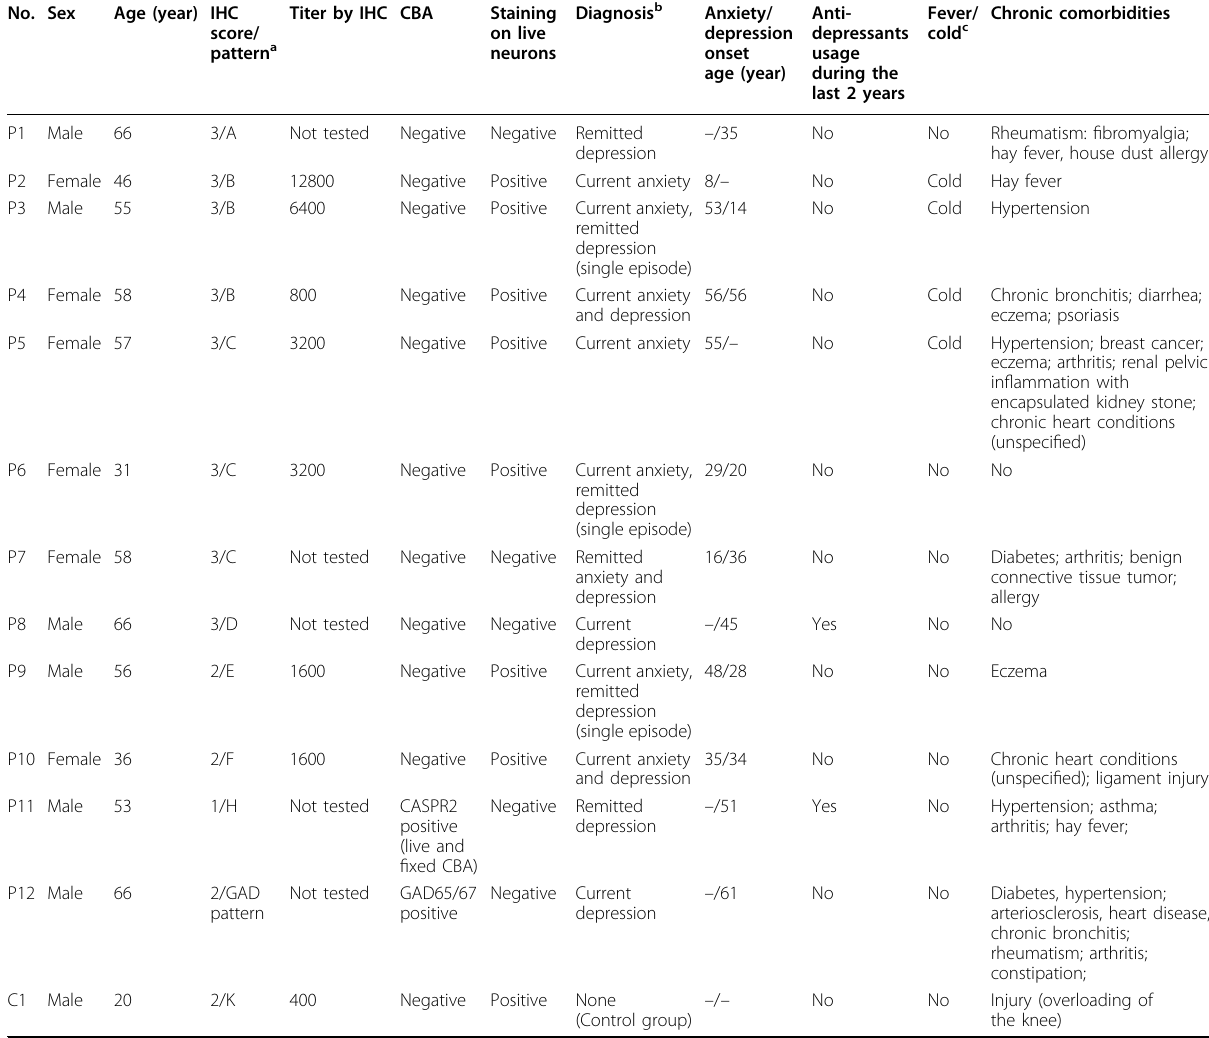
Table 3 Characteristics of the individuals with autoantibodies giving score 3 by IHC or positive for known or to novel NSAbs at wave